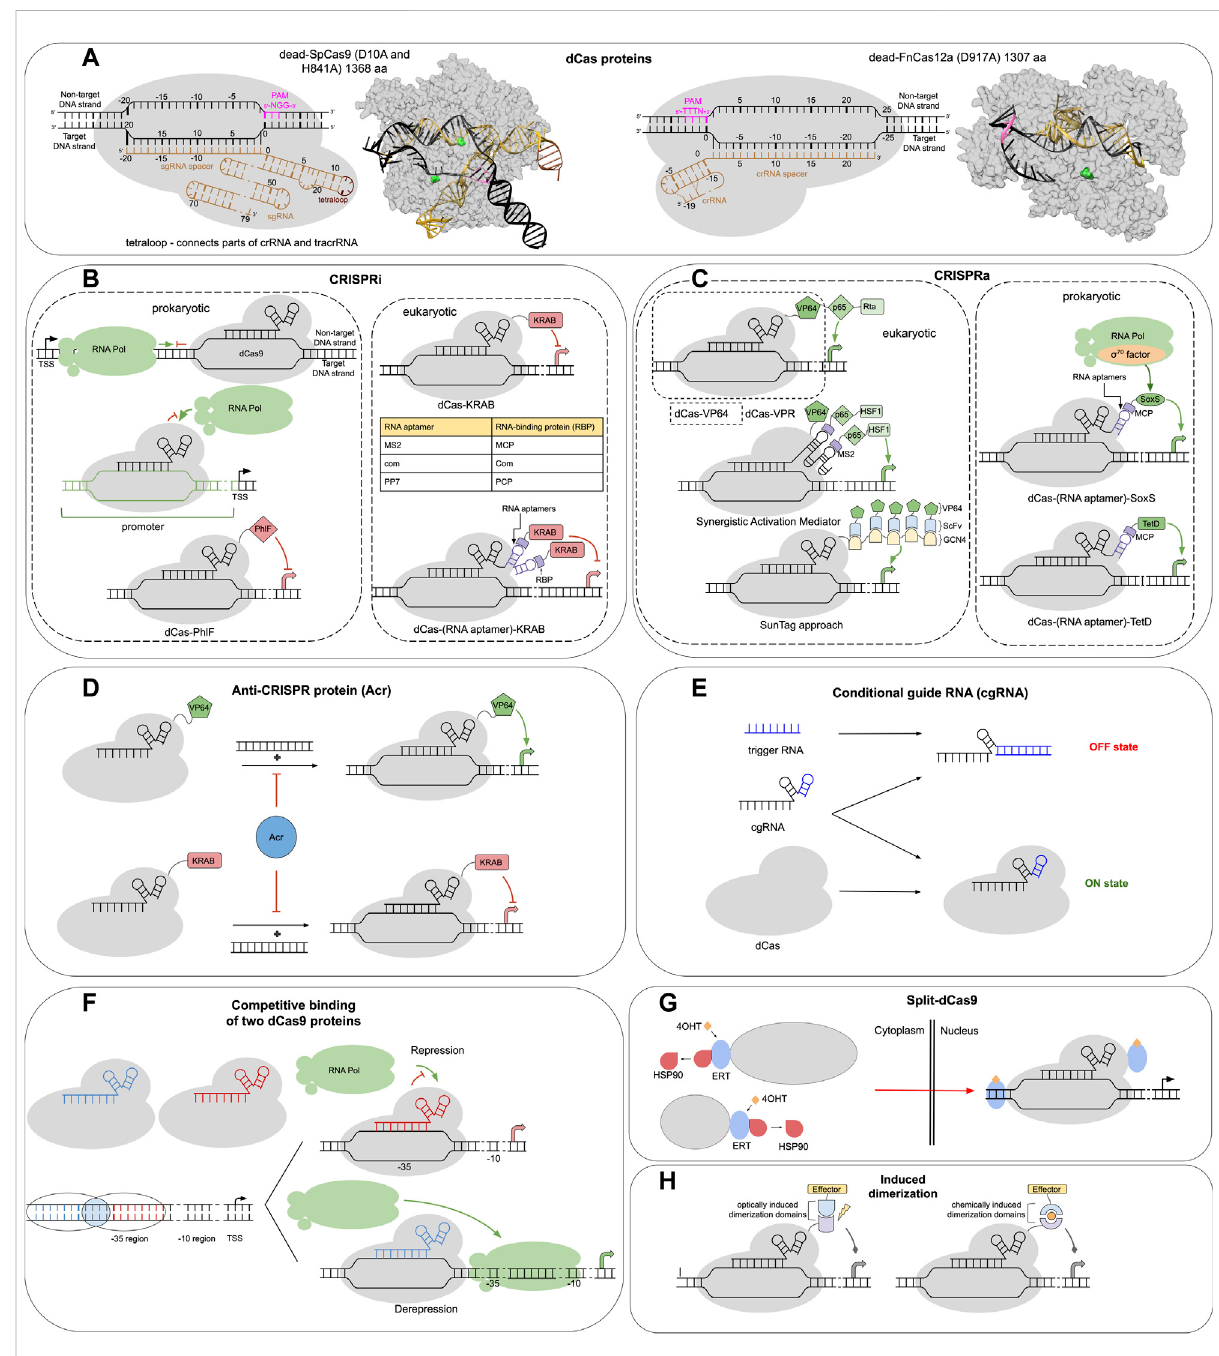
FIGURE 1 CRISPR-dCastoolboxforgeneticcircuitdesign. (A) SchematicandstructuralrepresentationofthedCasproteins:dead-SpCas9(left)anddead- FnCas12a (right). The colors of elements in the annotated schematic representations correspond to those in the structural representation. Amino- acid residues which are mutated in the dCas proteins are highlighted in green, PAM stands for protospacer adjacent motif. (B – H) dCas-based constructs that can be used for transcriptional gene expression control. (B) Principal schema of sequence-speci fi c gene repression using CRISPR interference (CRISPRi) in prokaryotes (left) and eukaryotes (right). (C) Various approaches to sequence-speci fi c gene activation using CRISPR-dCas systems (CRISPRa) in prokaryotes (right) and eukaryotes (left). (D) Additional regulation of CRISPRi and CRISPRa by Anti-CRISPR proteins (Acr). (E) Regulation of dCas activity via conditional sgRNA and trigger RNA. (F) Combination of two interfering CRISPR-dCas complexes for fi ne control of target gene expression. (G) Activation of split-dCas9 proteins fused to ERT domains of estrogen receptor (see text). (H) Additional control of sequence-speci fi c dCas targeting activity for gene expression regulation by chemical- or light-induced dimerization